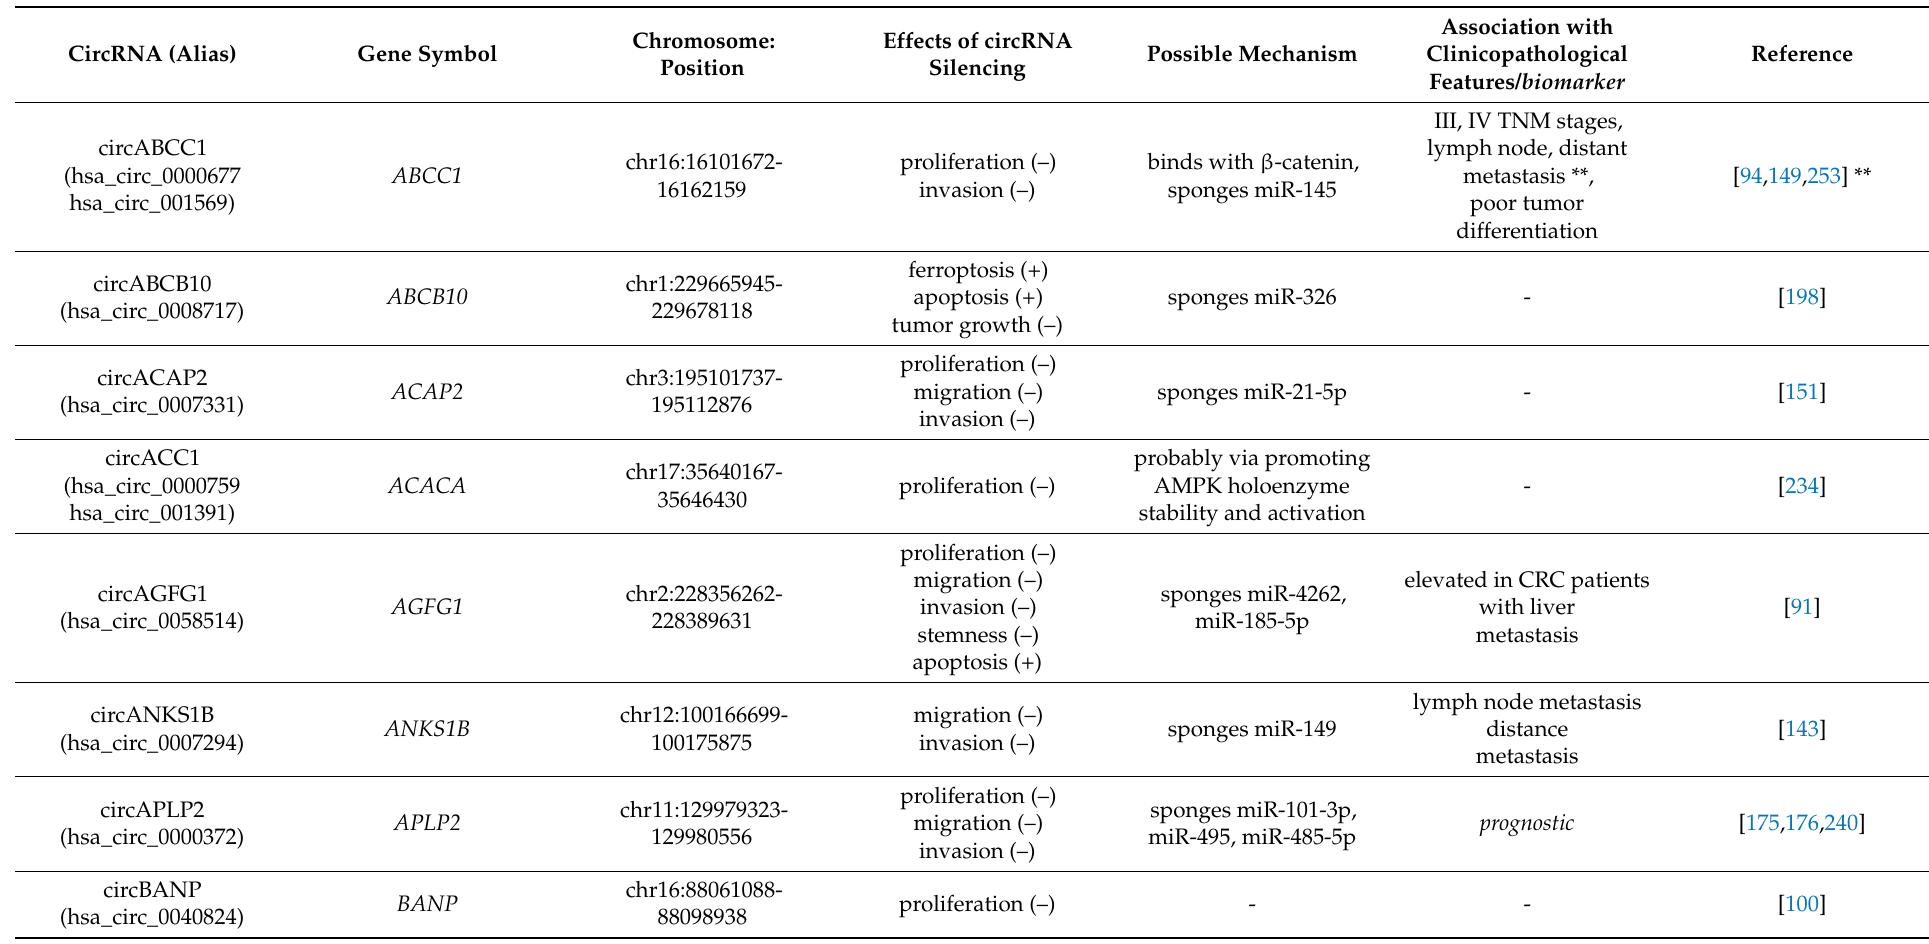
Table 1. Upregulated circRNAs involved in CRC progression and associated with CRC patients’ clinicopathological features